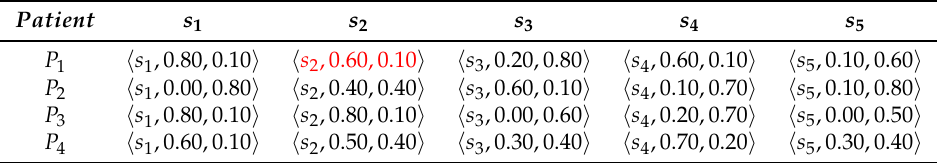
Table 10. The symptoms of the patients in Example 5.